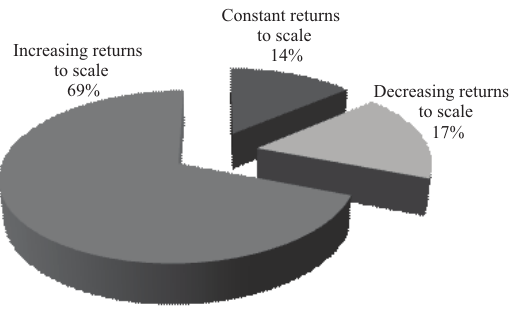
figure 4. Scale efficiencies for all listed real estate